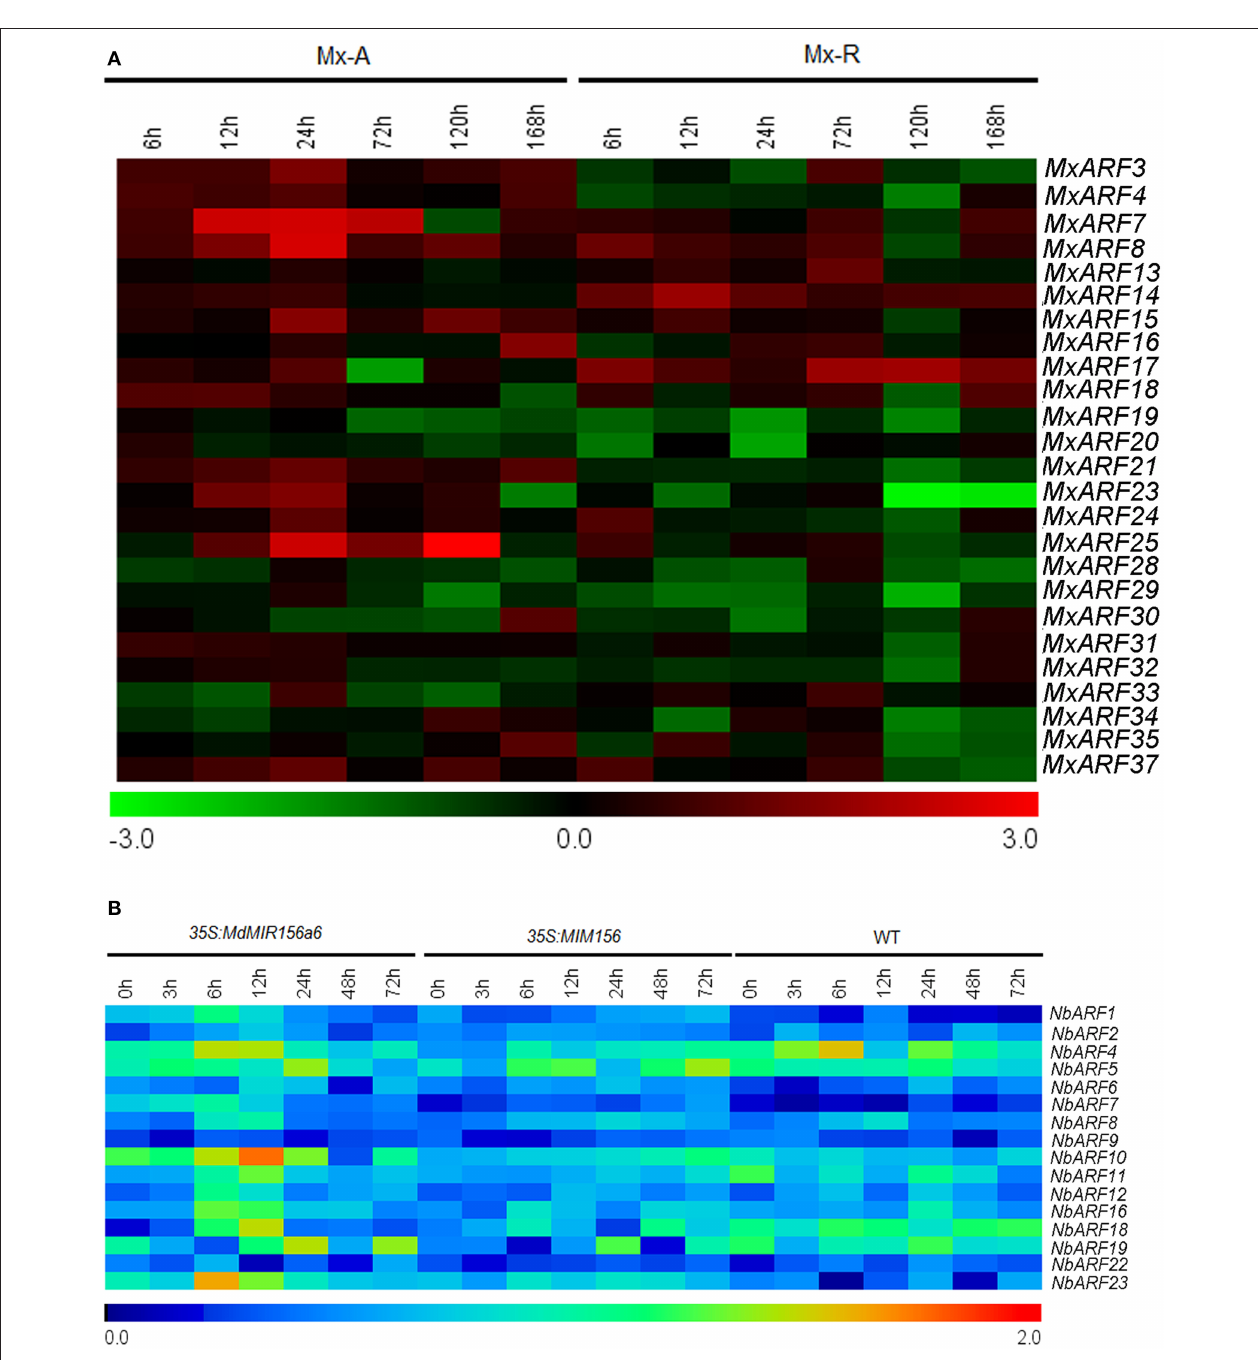
FIGURE 8 | Expression profiles of ARFs during adventitious rooting in Malus xiaojinensis and transgenic Nicotiana benthamiana . All the results of semi-quantitative RT-PCR were quantified using the ImageJ software. Log-transformed values of the relative expression levels of MxARF family genes under IBA treatment compared to controls were used for hierarchical cluster analysis with MeV 4.8.1. The color scale represents relative expression levels with red denoting up-regulation and green denoting down-regulation. The relative expression levels of NbARFs genes compared to NbEF1 α were used for hierarchical cluster analysis with MeV 4.8.1. Sampling times are indicated at top of the figure. (A) Expression profiles of MxARF genes in stem bark of Mx-A and Mx-R during adventitious root formation process after IBA treatment (original results show in Supplementary Figure 6 ). (B) NbARF genes expression patterns in WT, 35S:MdMIR156a6, and 35S:MIM156 transgenic tobacco stems during the adventitious rooting process (original results show in Supplementary Figure 7